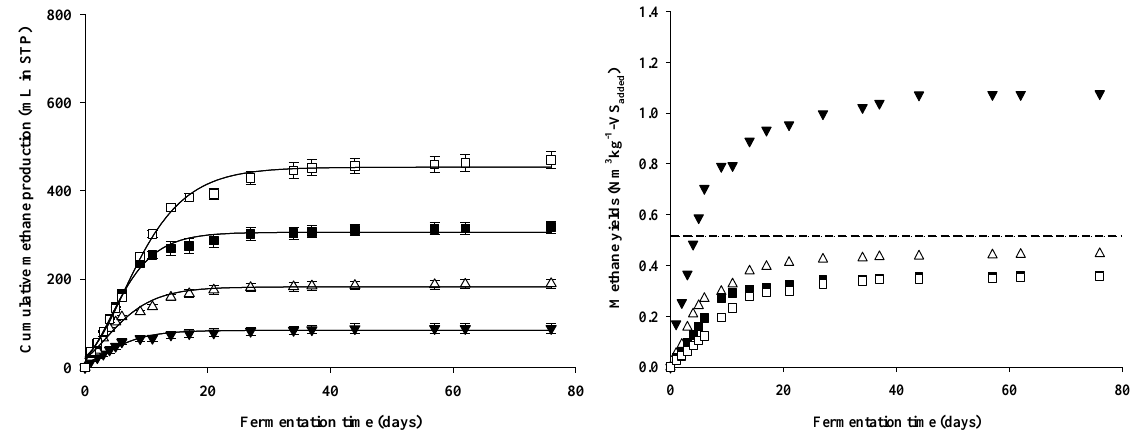
Figure 3. Cumulative methane production and yield from digestive tract contents during batch anaerobic digestion at different S/I ratios. ▼,  , ■, and □ indicate substrate to inoculum (S/I) ratios of 0.10, 0.50, 1.00, and 1.50, respectively, and --- is B th (0.517 Nm 3 /kg- VS added ). Vertical bars indicate standard